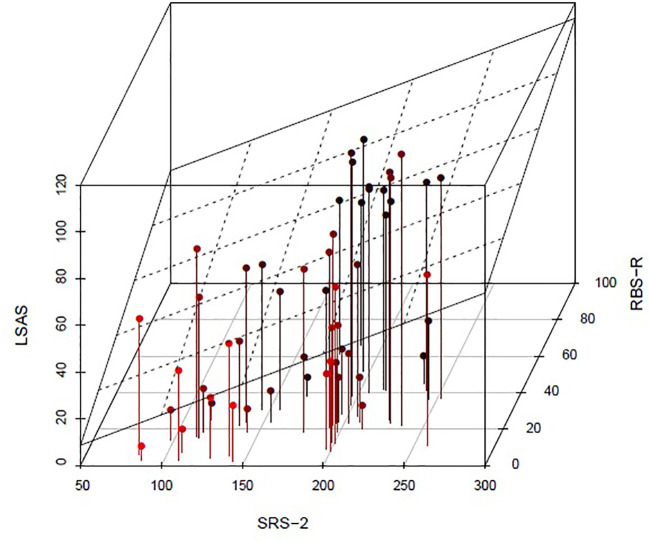
Relationship between LSAS, SRS-2, and RBS-R scores after adjustments with a 3 dimensions point cloud. The linear regression plan of the LSAS was represented. The dots are colored in black red gradient. The darker they are, the higher the RBS-R score is. On the frontal face of the square, the intersection with the regression plan with a strong positive angle shows a strong relationship between the LSAS and the SRS-2 scores even after adjustment on the RBS-R score. On the right lateral face, the intersection with the regression plan with a low positive angle shows a weaker relationship between the LSAS and the RBS-R scores after adjustment on the SRS-2 score. LSAS, Liebowitz Social Anxiety Scale; SRS-2, Social Responsibility Scale - 2; RBS-R, Repetitive Behavior Scale – Revised.